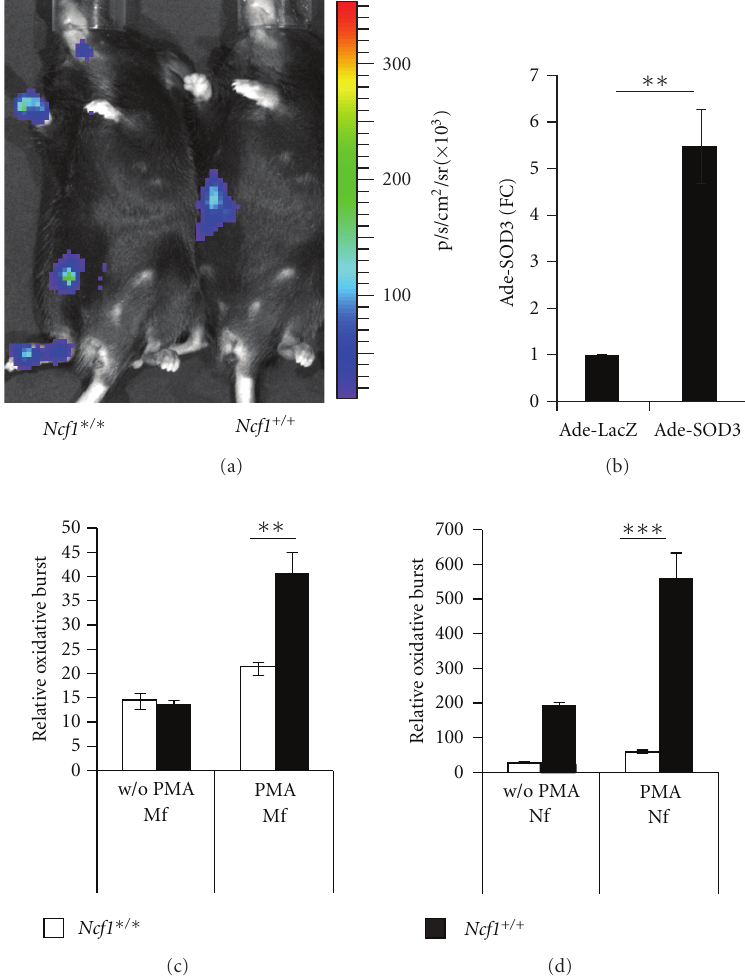
Figure 6: No oxidative burst was detected from the Ncf1 mutated mice. In vivo imaging with the ROS sensitive L-012 probe revealed a bright luminescent signal from the inflamed wild-type paws with CIA, while no signal was detected from Ncf1 ∗ / ∗ mice with comparable arthritis severity (a). Imaging was reproduced in two independent experiments with similar results. Expression of SOD3 by Ade-SOD3 expression vector in the treated paws was confirmed by Q-RT-PCR ( n = 7/group) (b). Ex vivo oxidative burst was measured from phagocytes from Ncf1 ∗ / ∗ ( n = 5) and wild-type mice ( n = 6) by using DHR-123 assay with and without (w/o) PMA stimulation. Neither macrophages (c) nor neutrophils (d) from the Ncf1 ∗ / ∗ mice were able to exert a measureable oxidative